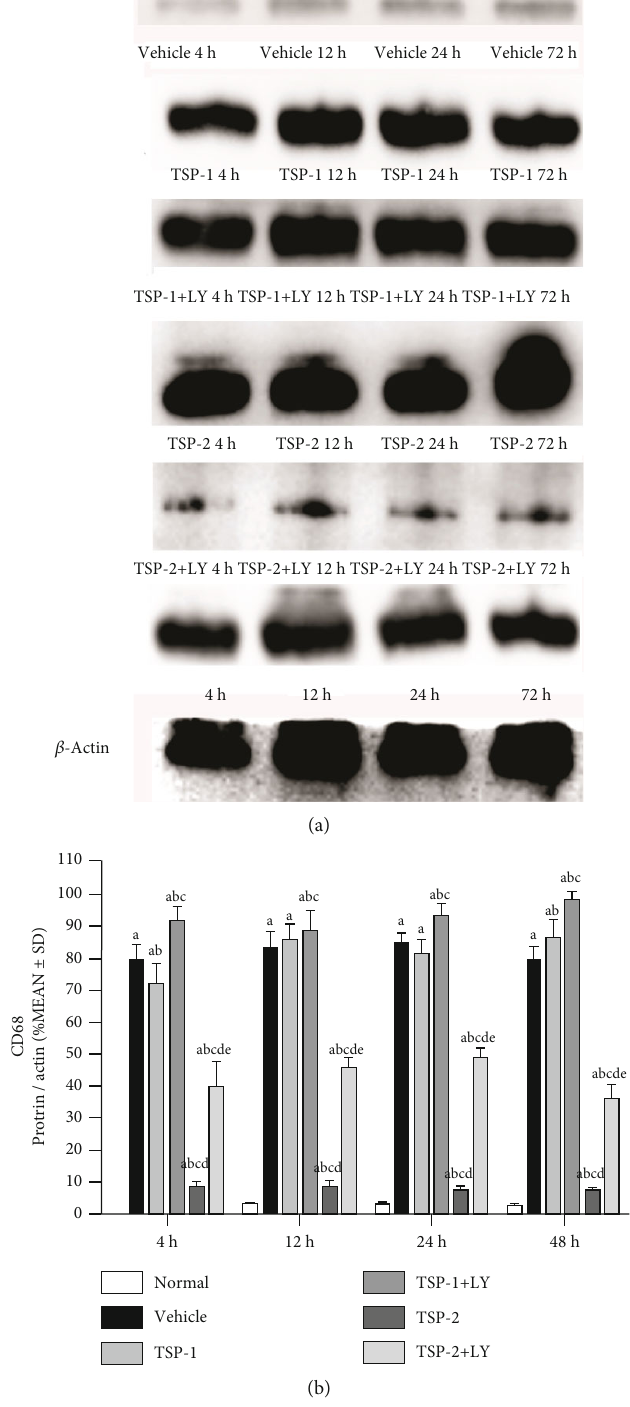
Figure 11: E ff ect of PI3K/Akt signaling inhibitor LY294002 on lung in fl ammation in vivo . The expression of CD68, a macrophage marker, in protein lysates of mice treated with LPS for 4, 12, 24, and 72h and overexpressing either empty vector (vehicle group), TSP-1 (TSP-1 group), or TSP-2 (TSP-2 group), as well as the TSP-1/TSP-2+LY204002 groups, are shown using Western blot analysis. β -Actin expression served as the loading control. The percentage of detected protein/actin is shown as mean ± SD . P value of < 0.05 represents signi fi cant di ff erence. a P < 0 : 05 compared with normal control; b P < 0 : 05 compared with vehicle control; c P < 0 : 05 compared with the TSP-1 group; d P < 0 : 05 compared with the TSP-1 transfected+LY294200 group; e P < 0 : 05 compared with the TSP-2 transfected group ( n = 4 per